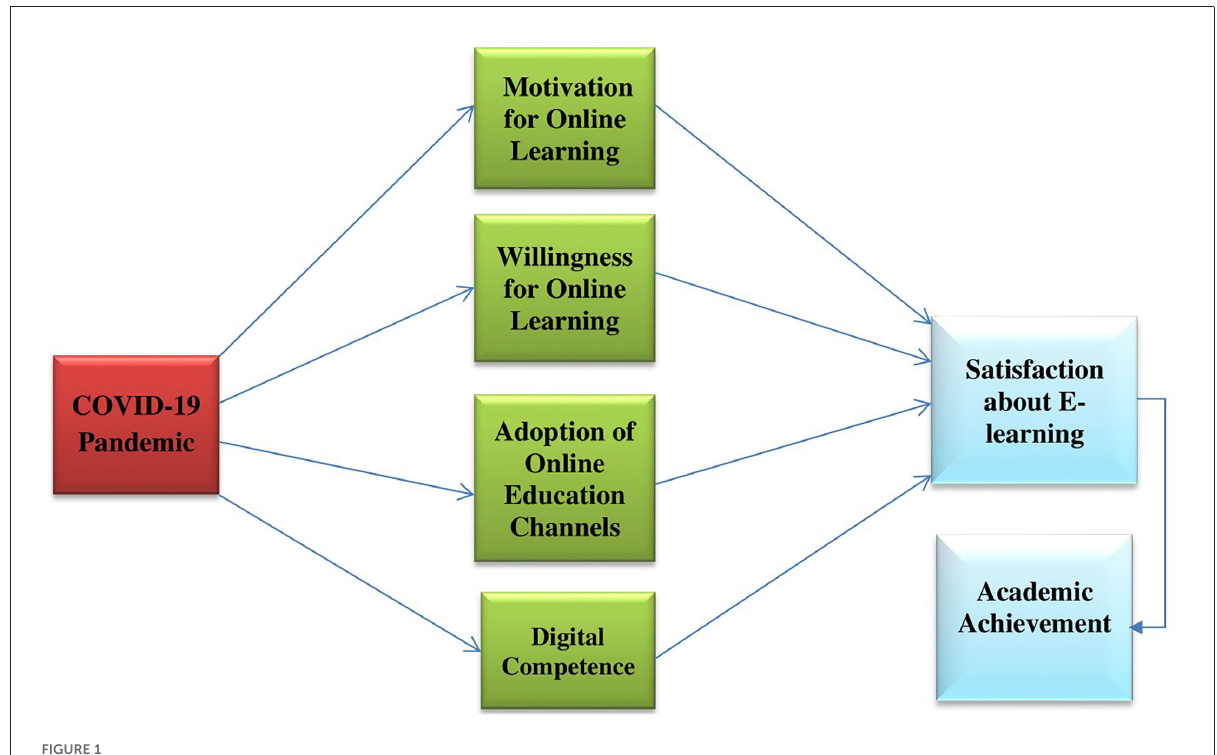
FIGURE1 Study conceptual